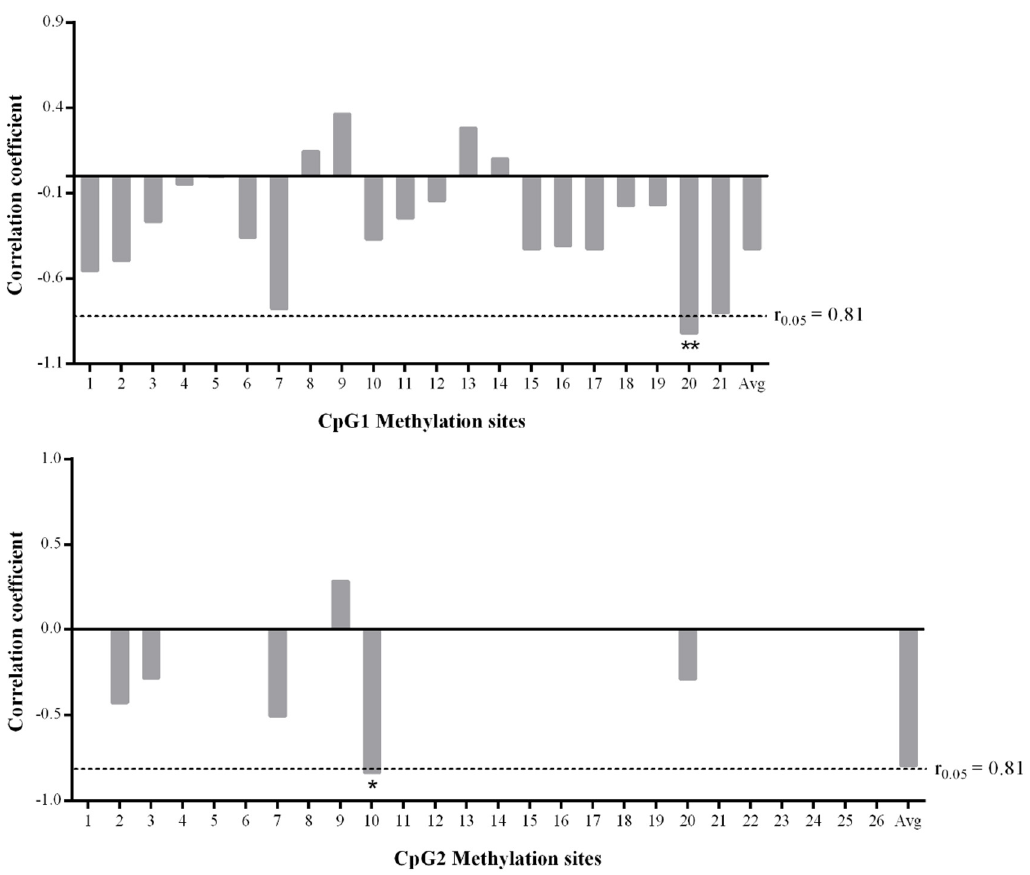
Figure 4. Analysis of correlation between the methylation levels of the CpG sites in the two CpG islands and mRNA expression. 1–21 of the top group mean the sites of CpG1, respectively. 1–26 of the bottom group mean the sites of CpG2, respectively. Avg means the averaged methylation level of all sites in each group ( n = 3). *, p < 0.05; **, p < 0.01.